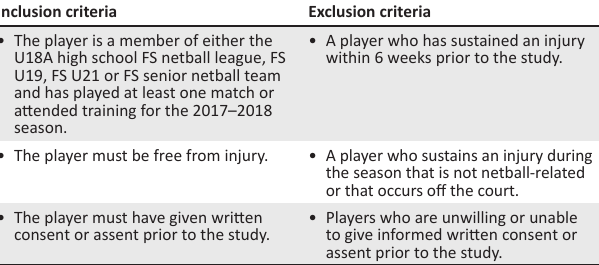
TABLE 1: Inclusion and exclusion